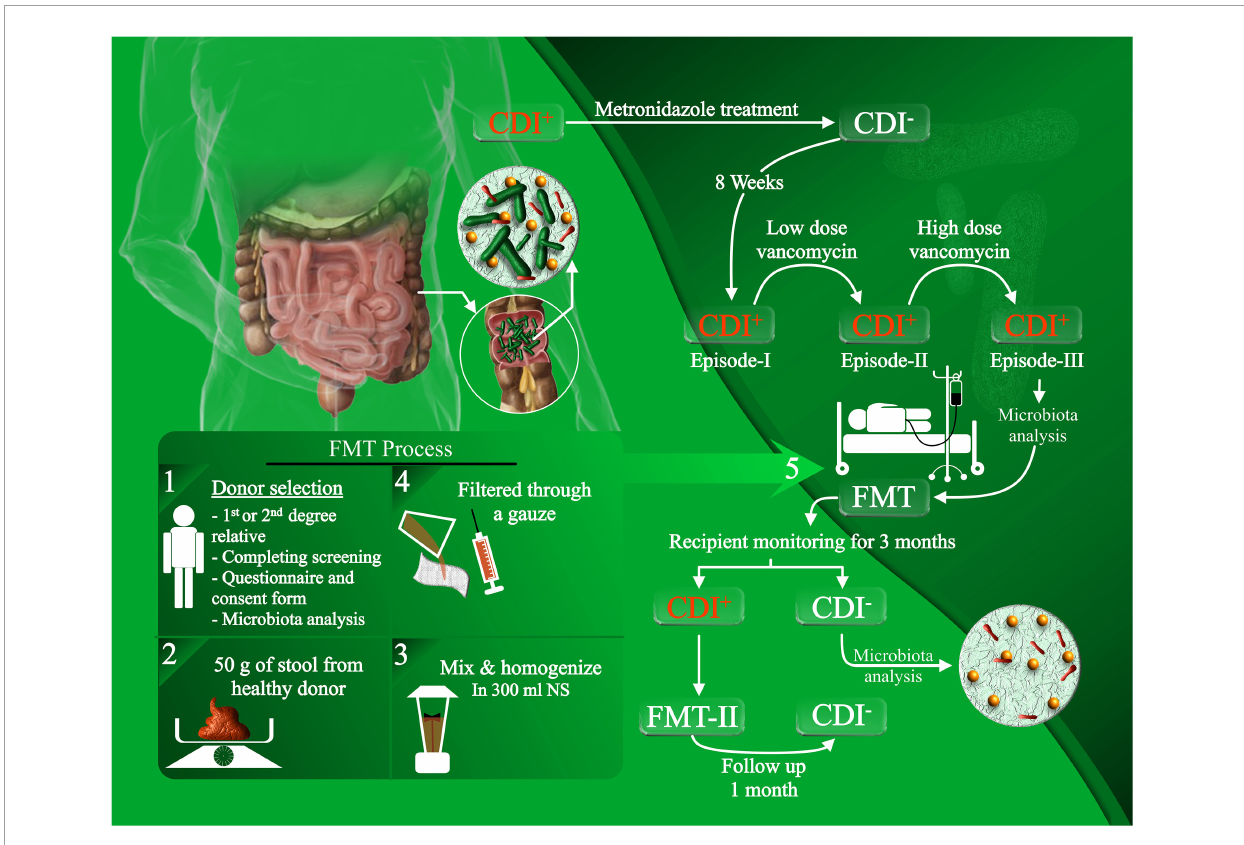
FIGURE1 Experimental design of the FMT procedure and patient recruitment. rCDI patients with concurrent IBD, who failed to eradicate the infection with antibiotic treatments, were recruited for FMT administration. The FMT procedure was conducted by selecting healthy donors, filtering and homogenizing the fecal material, and infusing the fecal suspension through colonoscopy. Stool samples were collected from the donors and recipients for microbiota analysis prior to FMT and after the